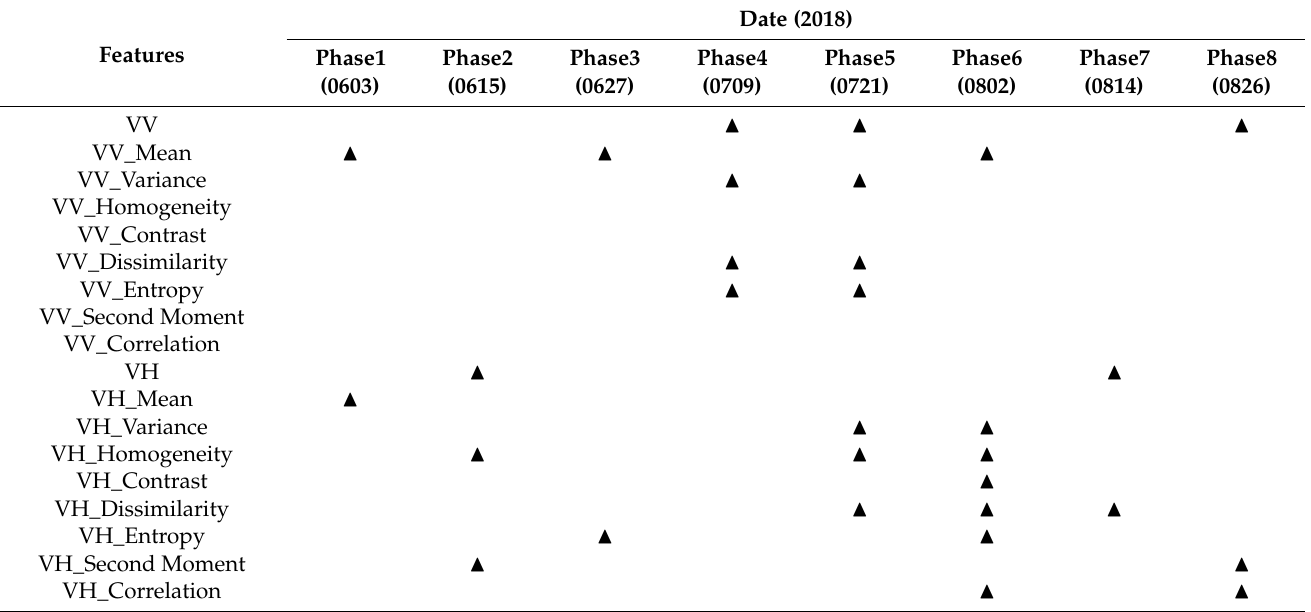
Figure 7. Temporal curves of SAR features in 2019. ( a ) Temporal curves of four classes; ( b ) temporal curve of rice. The light buffers refer to ± 1 σ from the mean. Table 4. Sensitivity of SAR features on different